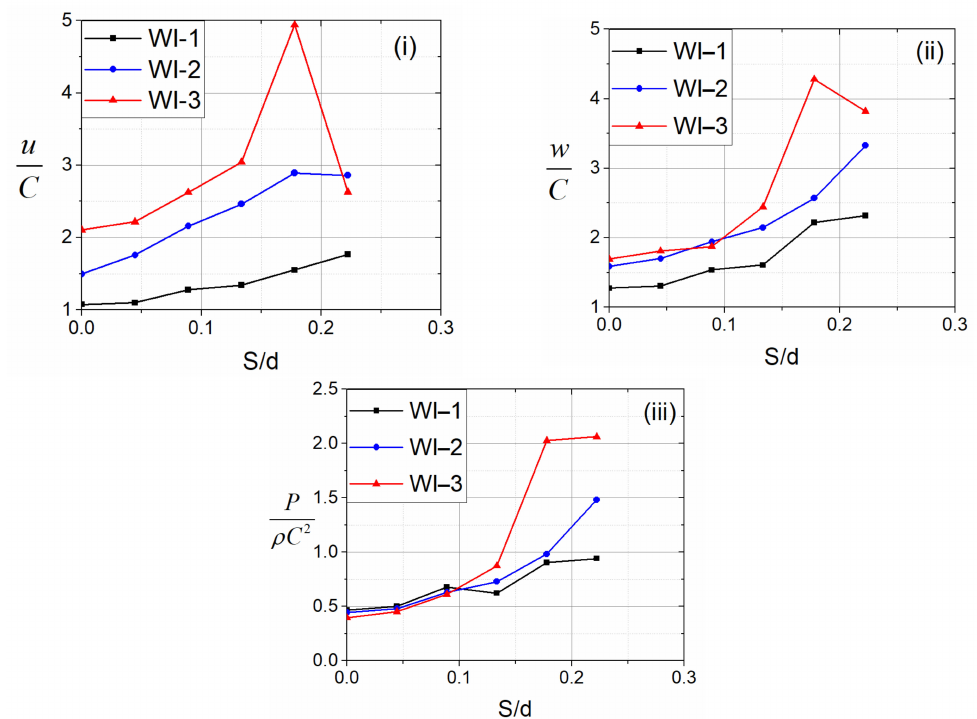
Figure 16. Comparison of maximum horizontal, vertical and pressure variation with the normalised airgap, S/d for three wave impact scenarios, WI-1, WI-2 and WI-3 ( i ) normalised horizontal velocity vs. S/d ( ii ) normalised vertical velocity vs. S/d and ( iii ) normalised pressure vs. S/d